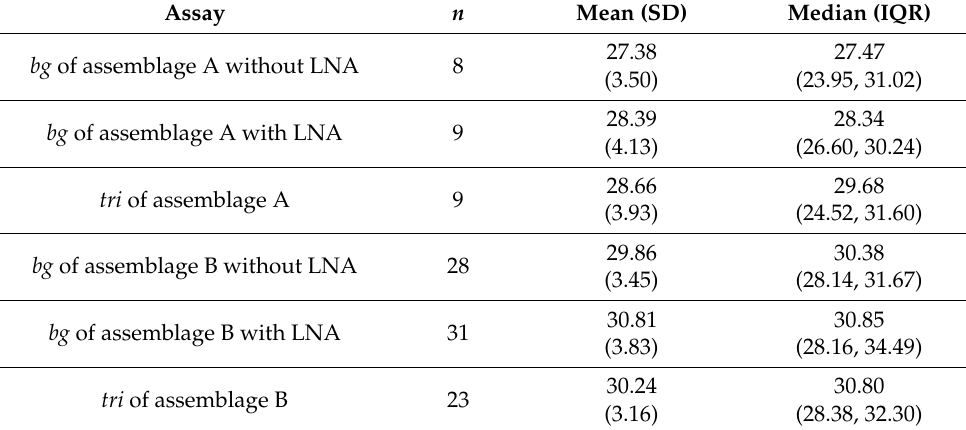
n = number of samples. SD = standard deviation. IQR = interquartile range.